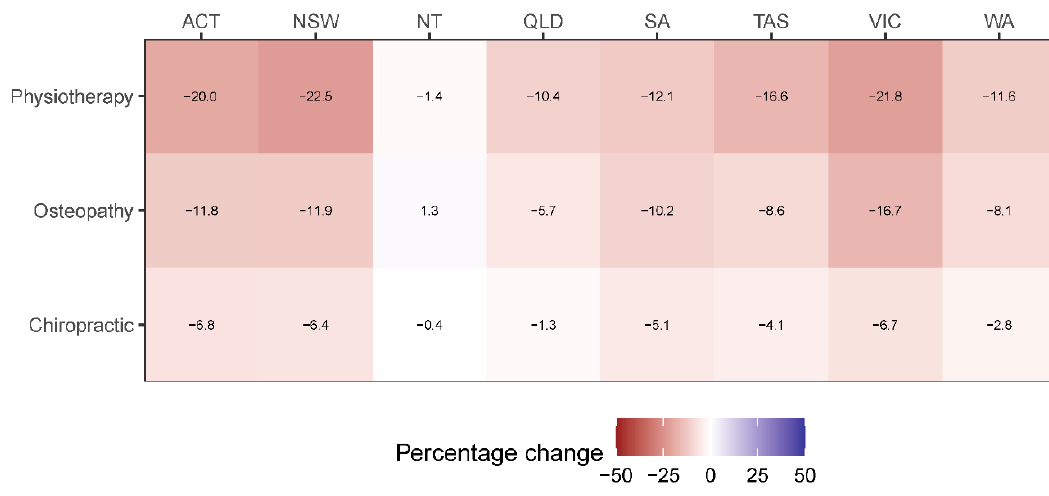
Figure 4. Heatmap of the estimated mean percentage error in total cost of services provided by each manual therapy profession during the first half of 2020 across Australian states and territories.